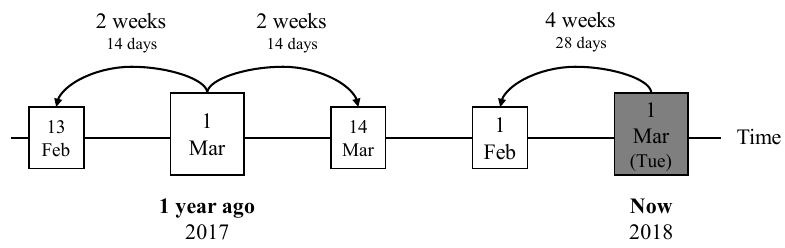
Figure 4. Range of input days used in the similar day model.